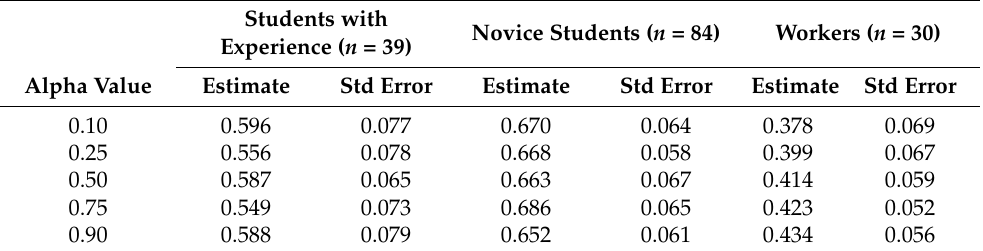
Table 6. Range of alpha values and corresponding parameter estimates and standard